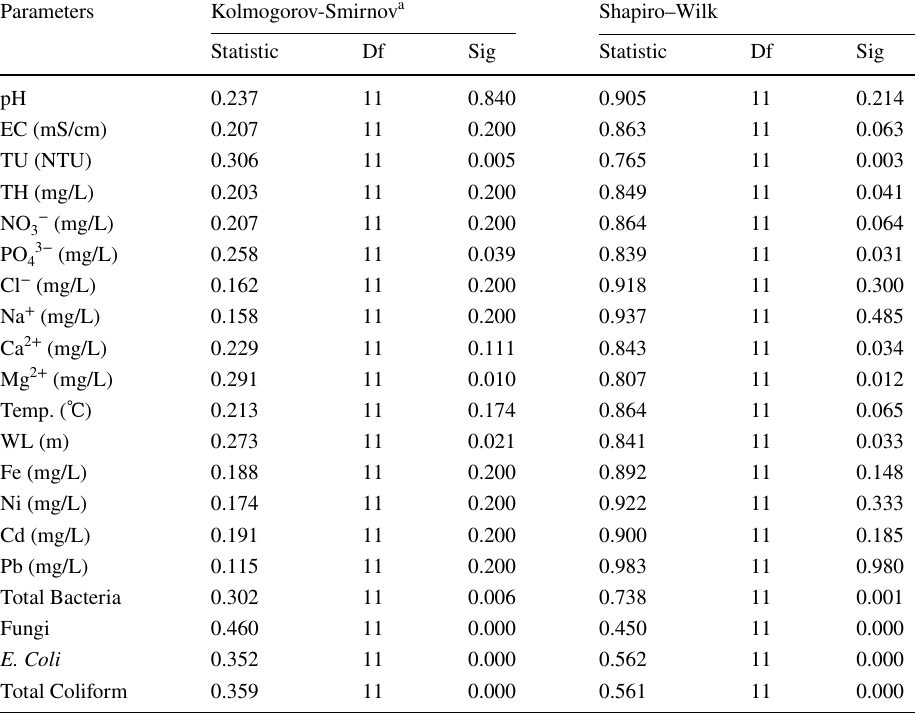
Table 6 Normality test of the